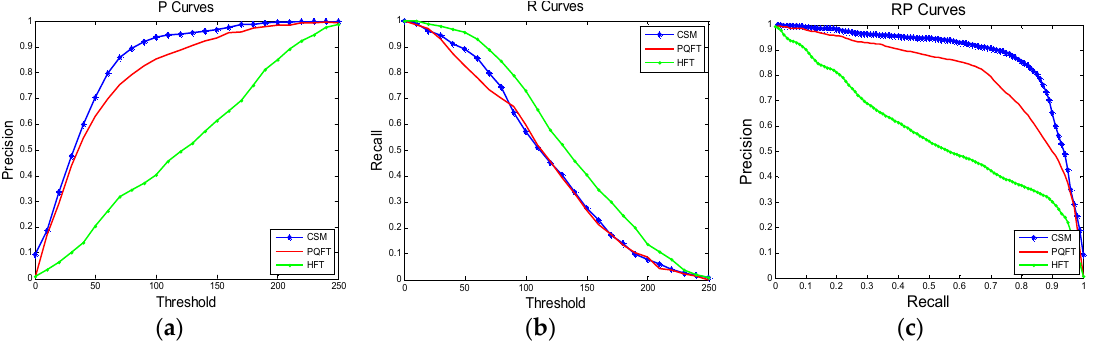
Figure 13. Performance comparison: ( a ) Precision curves; ( b ) Recall curves; ( c ) RP curves.